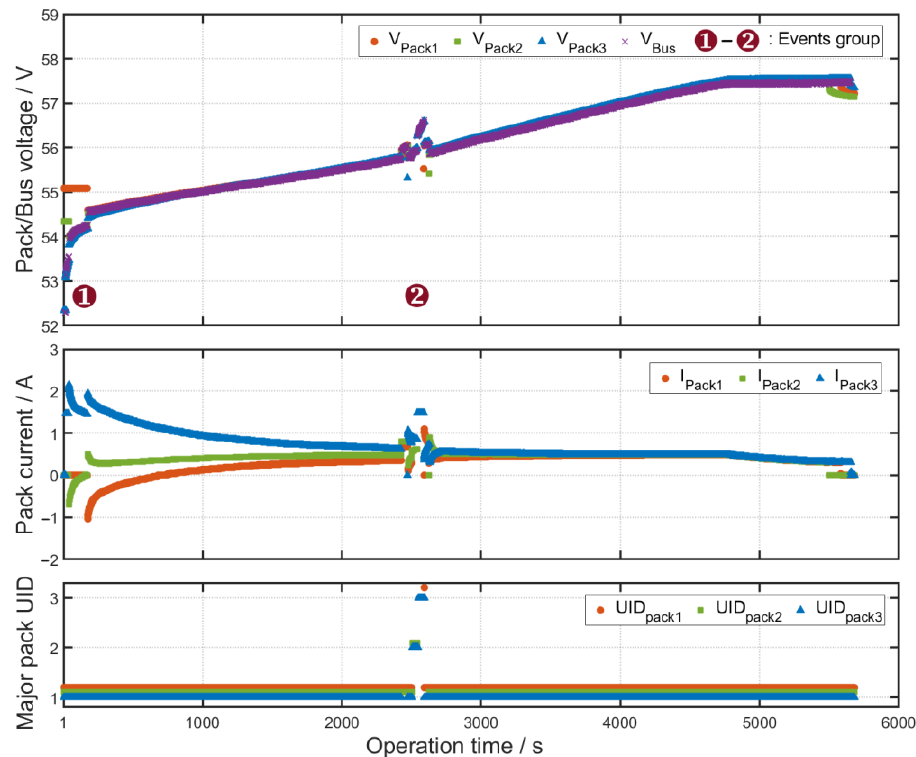
Figure 8. Data of a battery power network during a charging cycle.